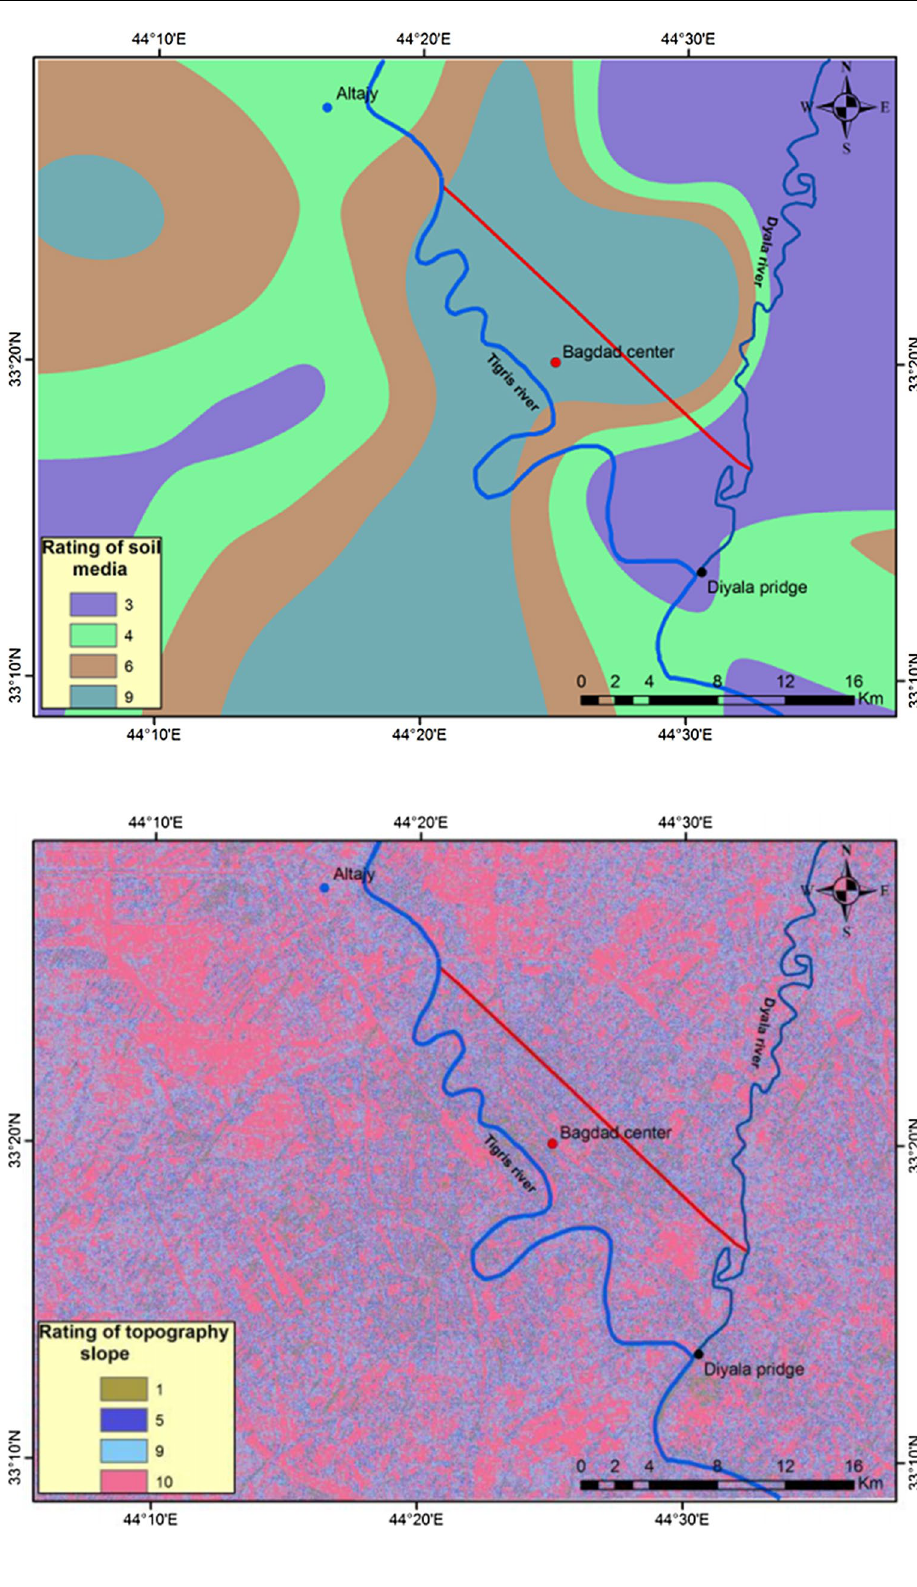
Fig. 9 Rating of soil media map of the study area